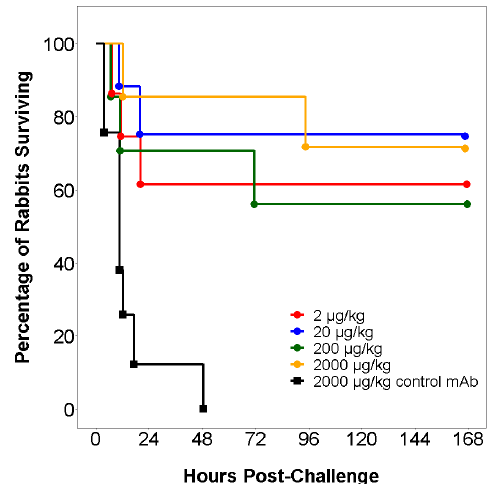
Figure 1. Time-course of animal survival in a lethal rabbit bacteremia model, where animal cohorts (8 per group) received either an intravenous inactive control antibody or one of four BB200 dose levels and then 24 h later challenged with a 100% lethal inoculum of K. pneumoniae ST258 (5 × 10 9 CFU/kg) adapted from reference [32].